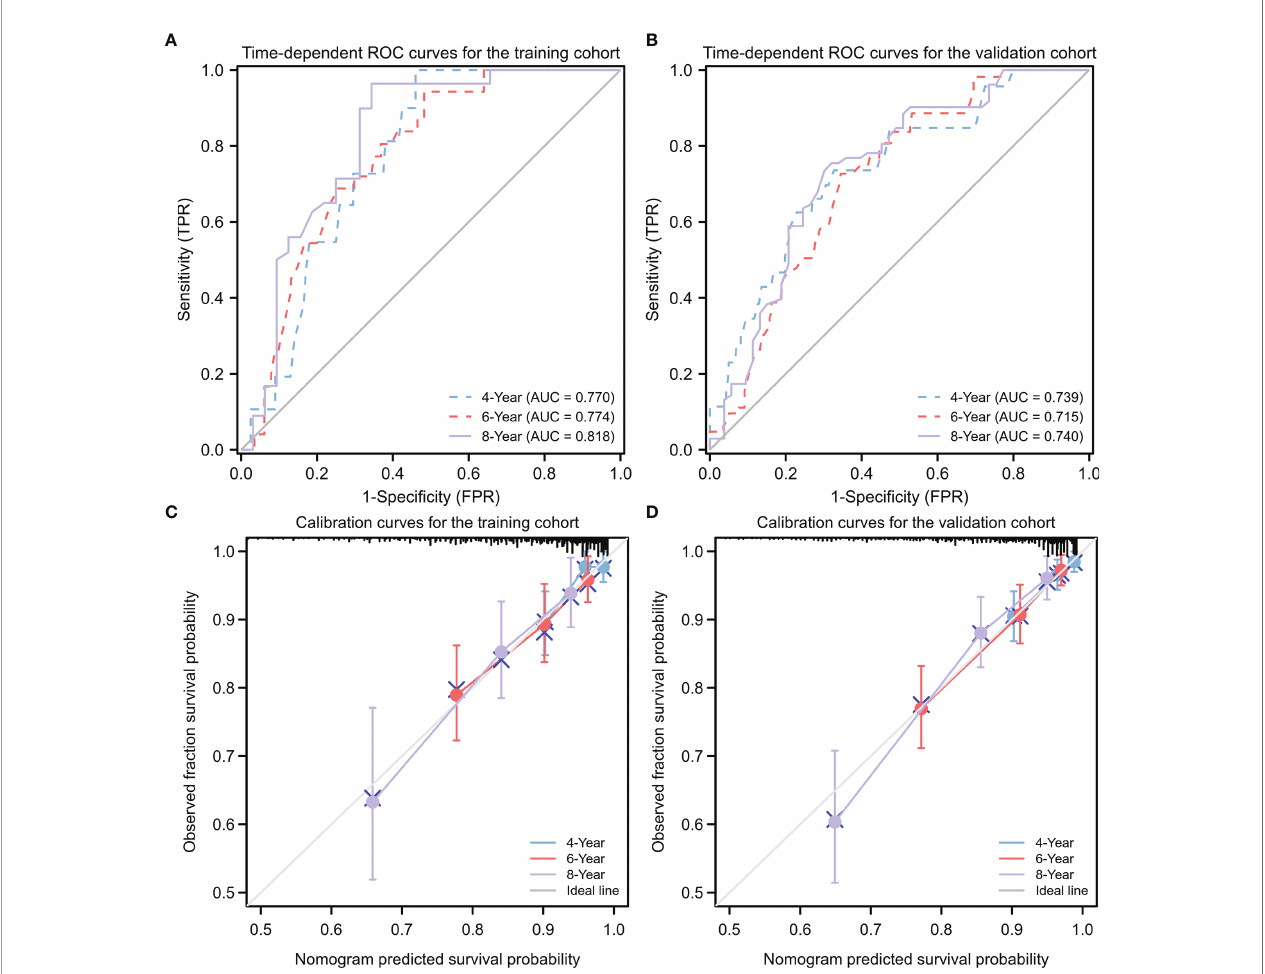
FIGURE 6 | Predictive performance for nomogram model. (A, B) Time-dependent ROC analysis of nomogram for 4-, 6-, and 8-year progression-free survival (PFS) probabilities in training cohort (A) and validation cohort (B) , respectively. (C, D) Calibration plots of the nomogram for the training (C) and validation (D) cohorts at 4, 6, or 8 years. ROC, receiver operating characteristic; TPR, true positive rate; FRR, false positive